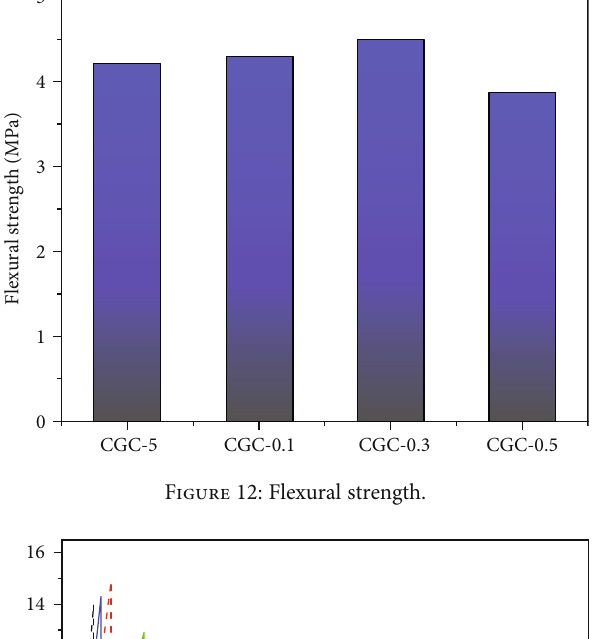
Figure 14: Complete stress-strain curve of concrete.